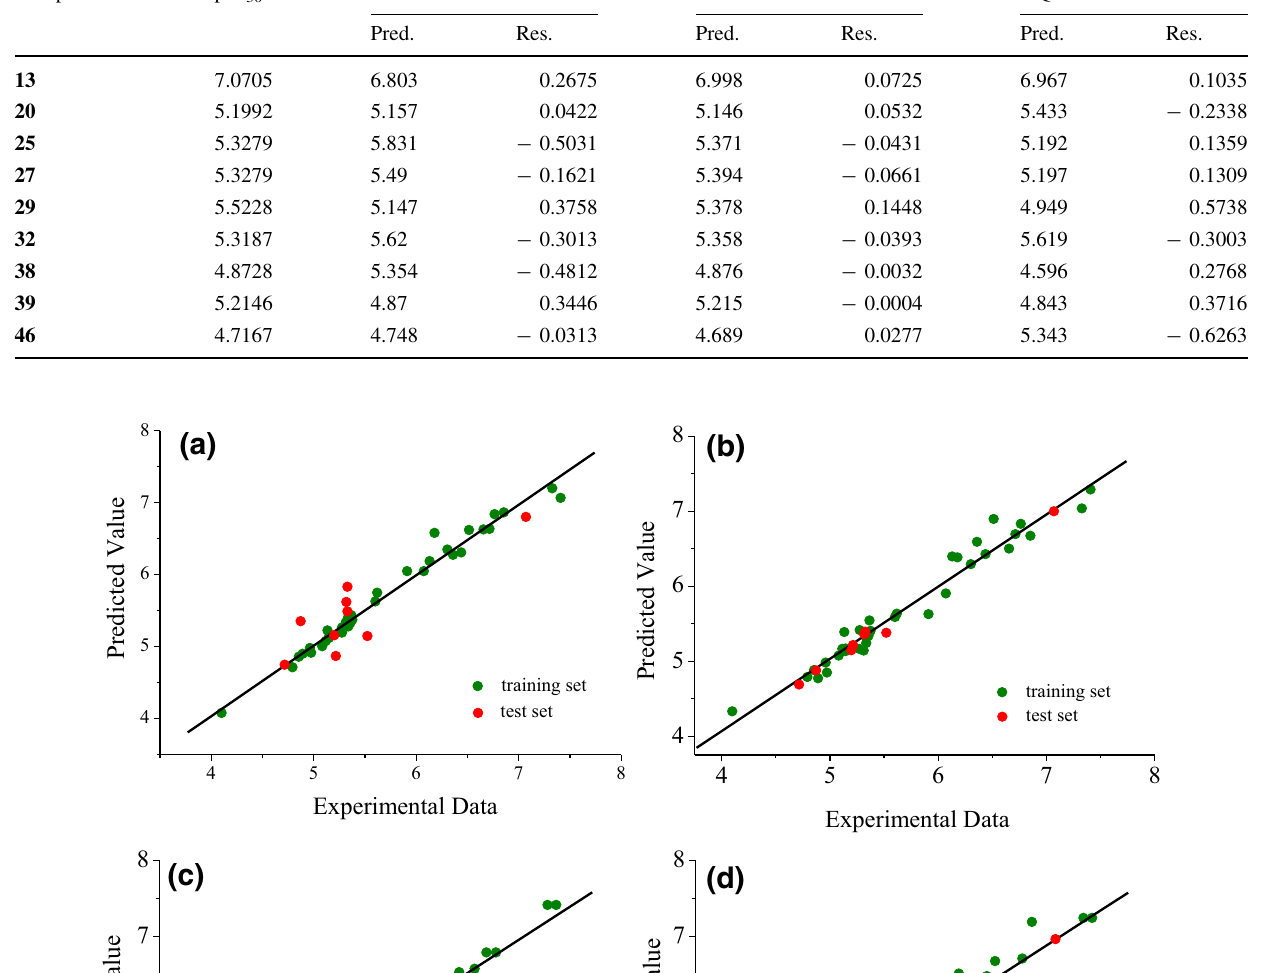
Table 5 Experimental dates, prediction values and its residues of the test set used for the CoMFA, CoMSIA and HQSAR Compounds